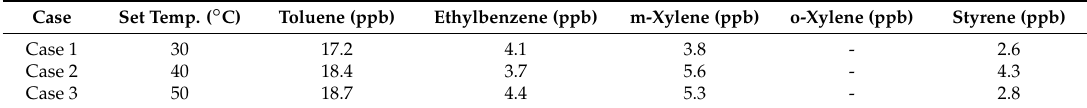
Table 7. Background concentration of test